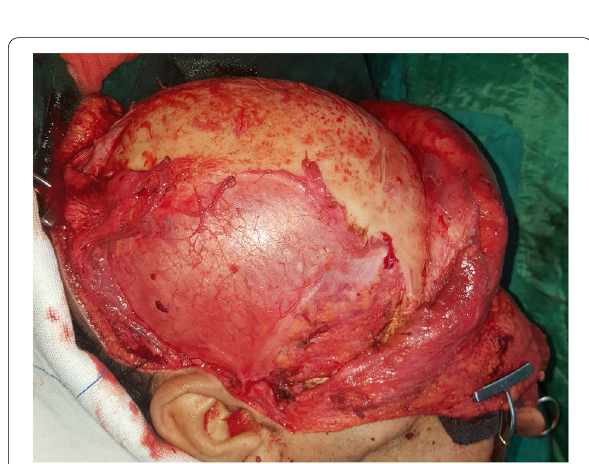
Fig. 5 The temporalis muscle before elevation